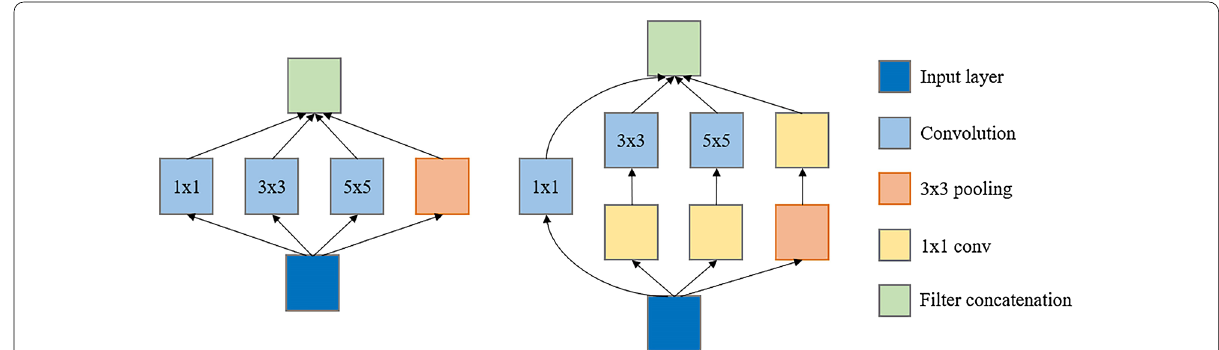
Figure 5 Inception module: ( a ) Inception module, naïve version; ( b ) Inception module with dimension